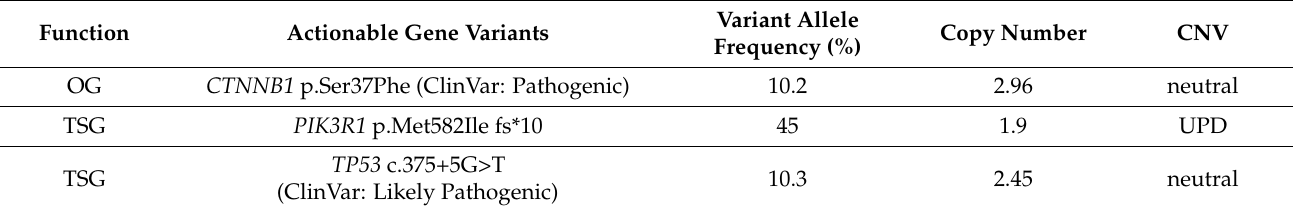
Table 1. Actionable variants in the uterine